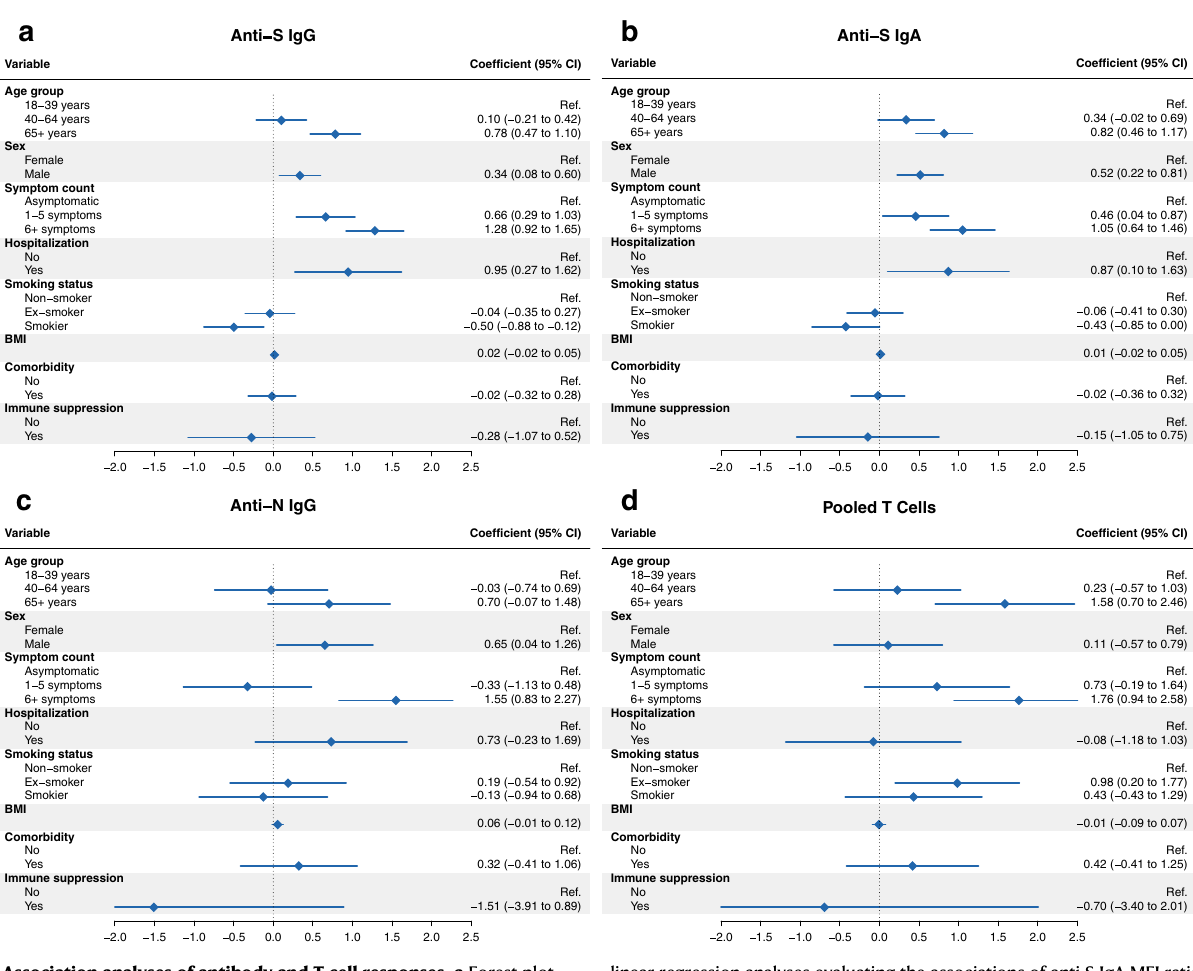
linear regression analyses evaluating the associations of anti-S IgA MFI ratios with demographicandclinicalfactorsintheoverallstudypopulation.Modeladjustment as for panel a . c Forest plot showing results from adjusted mixed linear regression analyses evaluating the associations of anti-N IgG MFI ratios with demographic andclinicalfactorsinthesubsample(total n =64).Modeladjustmentasforpanel a . d Forestplotdemonstratingresultsfromadjustedmixedlinearregressionanalyses evaluating the associations of pooled T cells (summed M, N, S1, and S2 spot- forming units (SFU) per 1e6 peripheral blood mononuclear cells (PBMCs)) with demographic and clinical factors in the subsample. Model adjustment as for panel a . Source data are provided as a Source Data fi